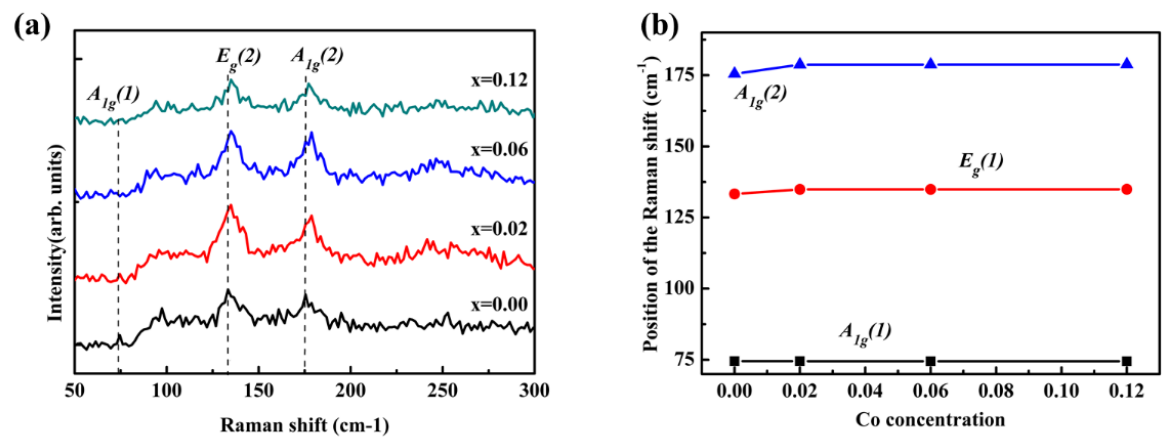
Figure 3. ( a ) The Raman spectra of Co x Bi 2-x Se 3 single crystals; ( b ) the position of Raman peaks. (Note: the red points, blue triangers and black squares represent the Raman shift of the E g (1), A 1g (2) and A 1g (2) vibration mode of the samples with the different Co doping concentrations.).